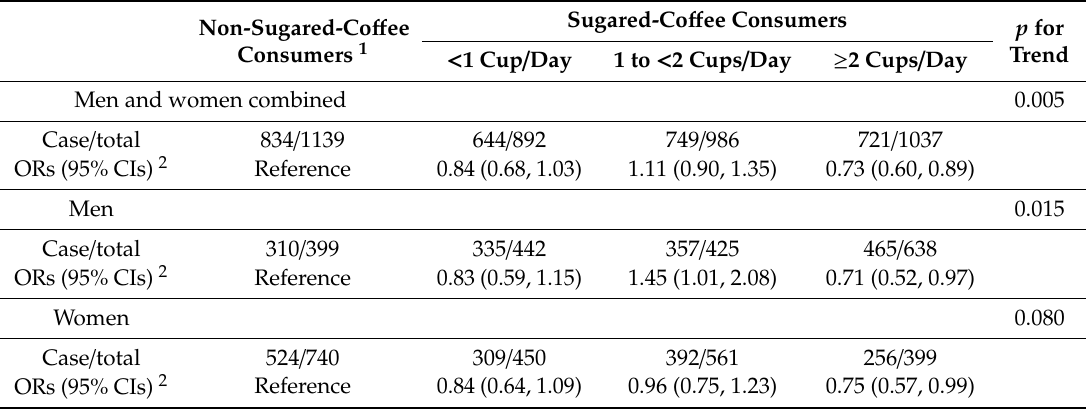
Table 4. Multivariate-adjusted ORs and 95% CIs for the risk of prediabetes and type 2 diabetes combined according to sugared co ff ee